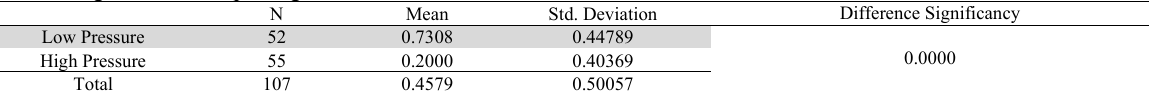
The Average of Fraud